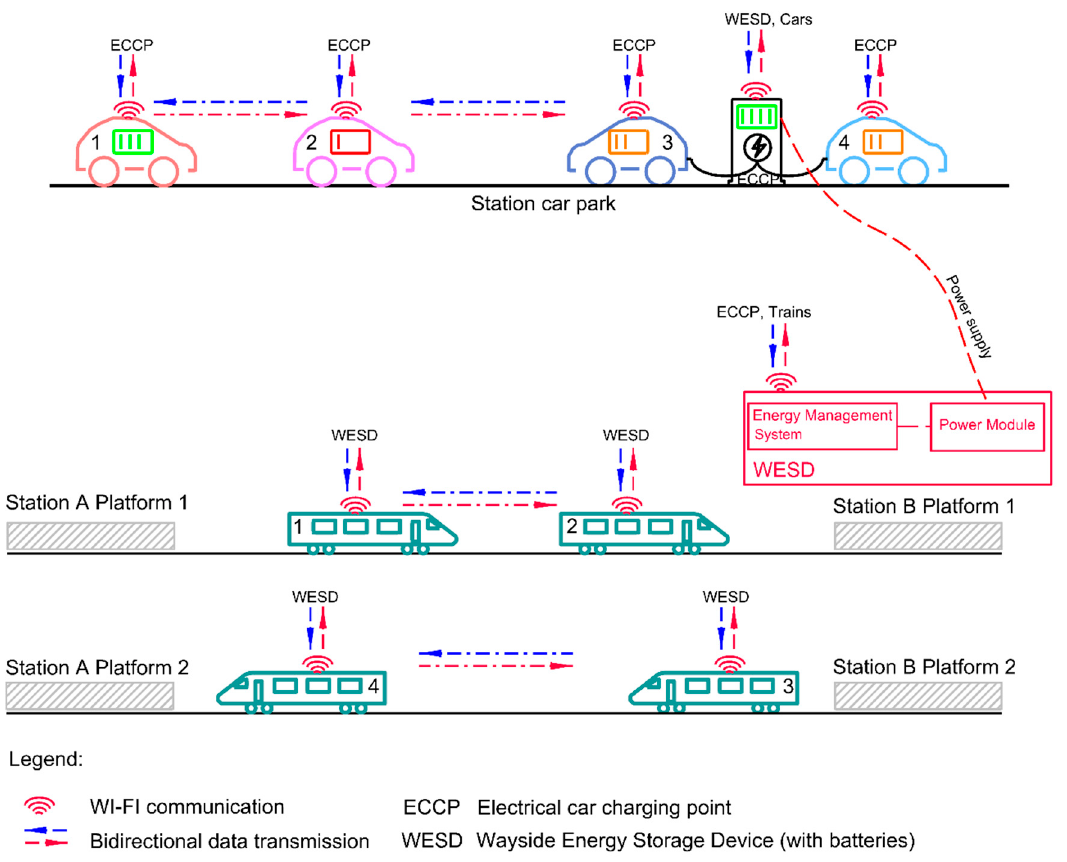
Figure 15. Communication architecture between charging point, trains, cars and WESD.